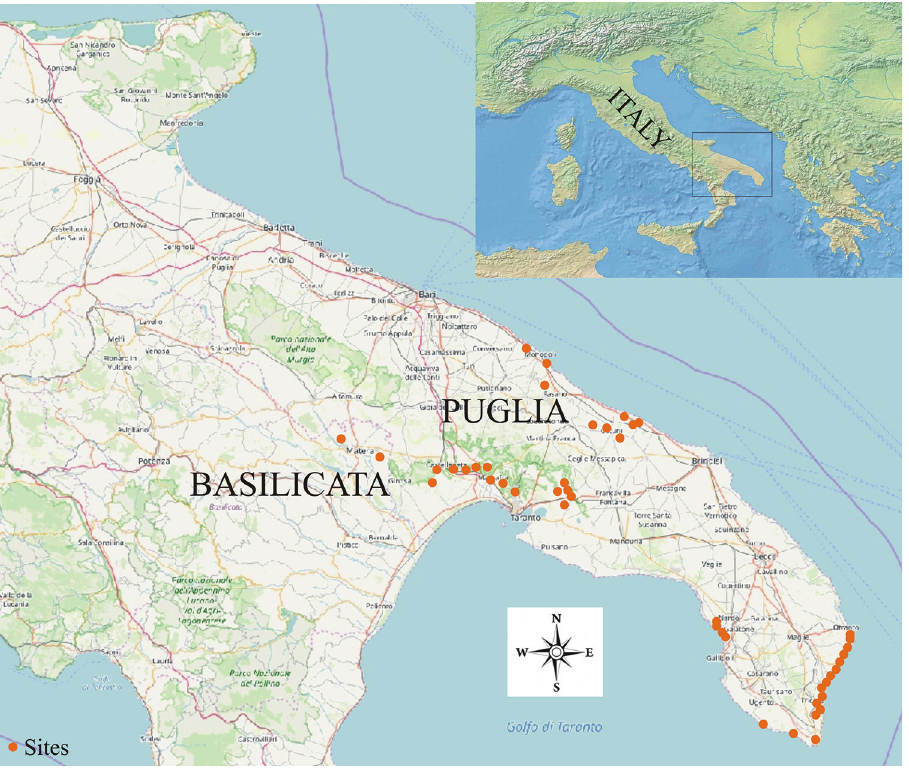
Figure 8. Geographic range and distribution map of Scrophularia lucida L. Maria d’Agnano (Ostuni; observations by P. Medagli), Lamaforca and Torre Santa Sa- bina (Carovigno; Province of Brindisi; observation by E.V. Perrino); several more or less continuous localities in Salento from Otranto to S. Maria di Leuca, and other